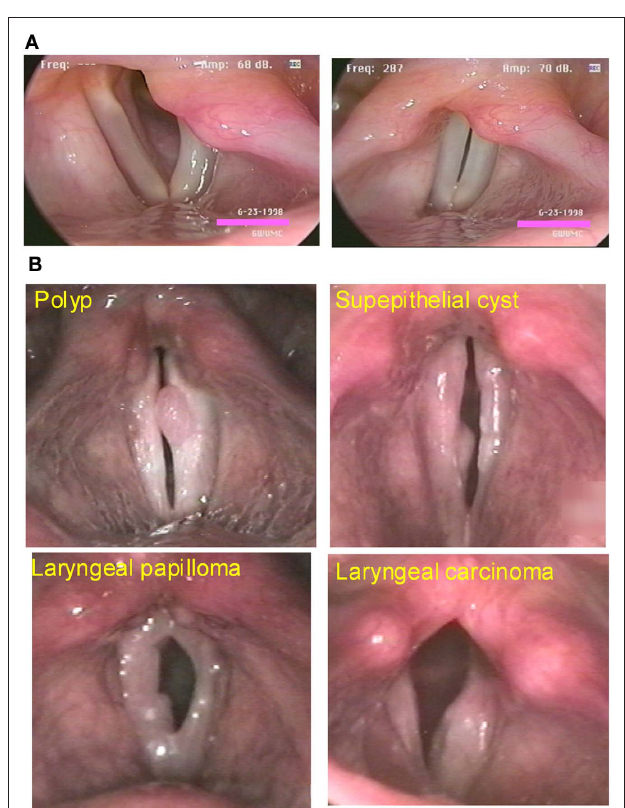
Figure 3 | (A) Abduction and adduction of the larynx in a patient with a vocal fold paresis on the left side of the image. (B) Some common illnesses that affect vocal fold closure.